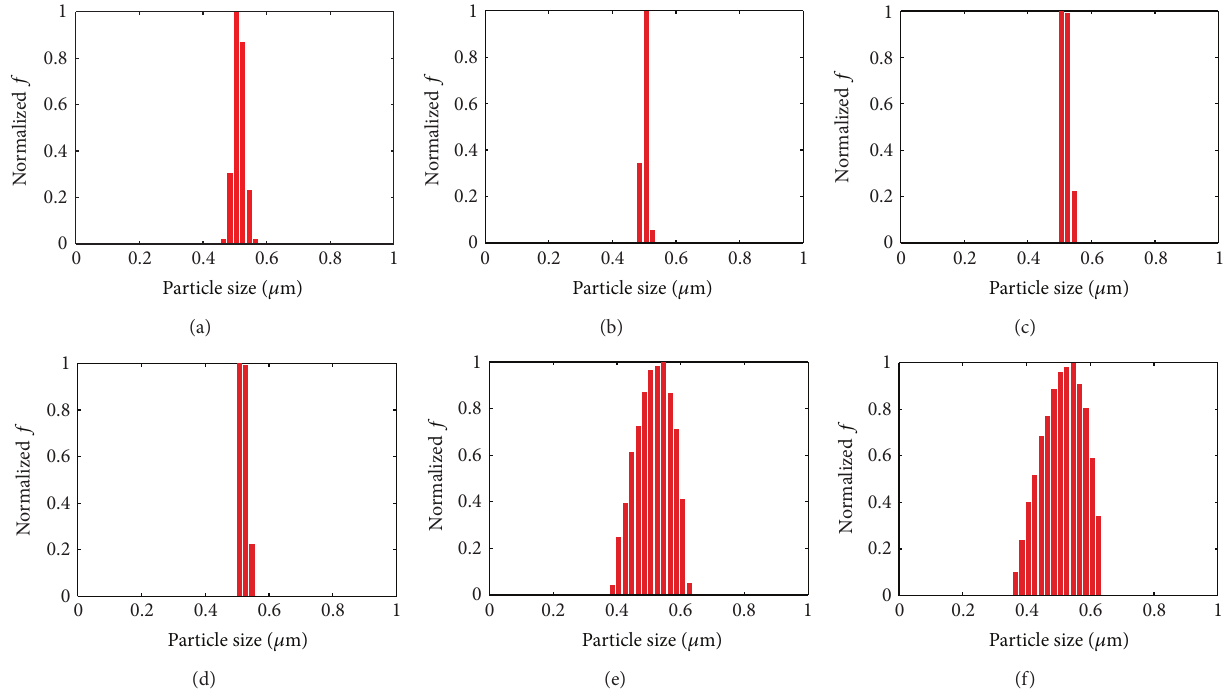
Figure 5: Retrieved particle size distribution of the polystyrene suspension via (a) least square fit, (b) Chahine method, (c) Active-Set, (d) NNLS, (e) Landweber-Bialy, and (f) projected Landweber approach for 250 size classes for 𝑥